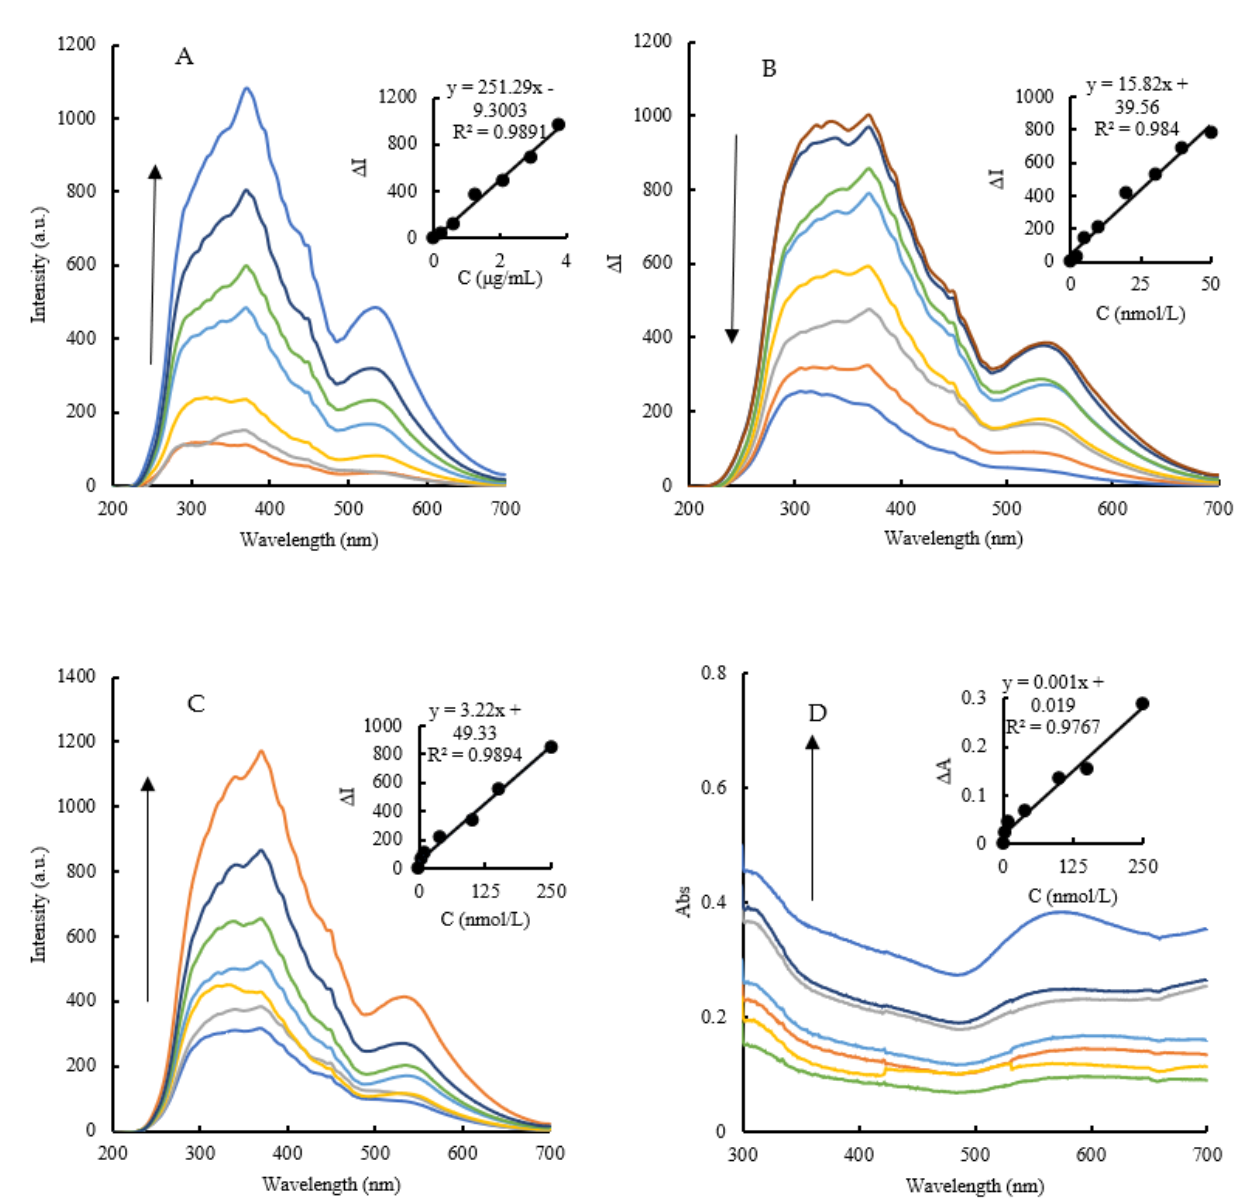
Figure 5. RRS and Abs spectra of the CD N catalytic amplification system. ( A ): RRS spectra of CD N – Et – HAuCl 4 system, (0, 0.21, 0.63, 1.26, 2.1, 2.94, 3.78) μg/mL CD N + 9.97% Et + 0.5 mmol/L HCl + 0.07 mg/mL HAuCl 4 ; ( B ): RRS spectra of Apt As –